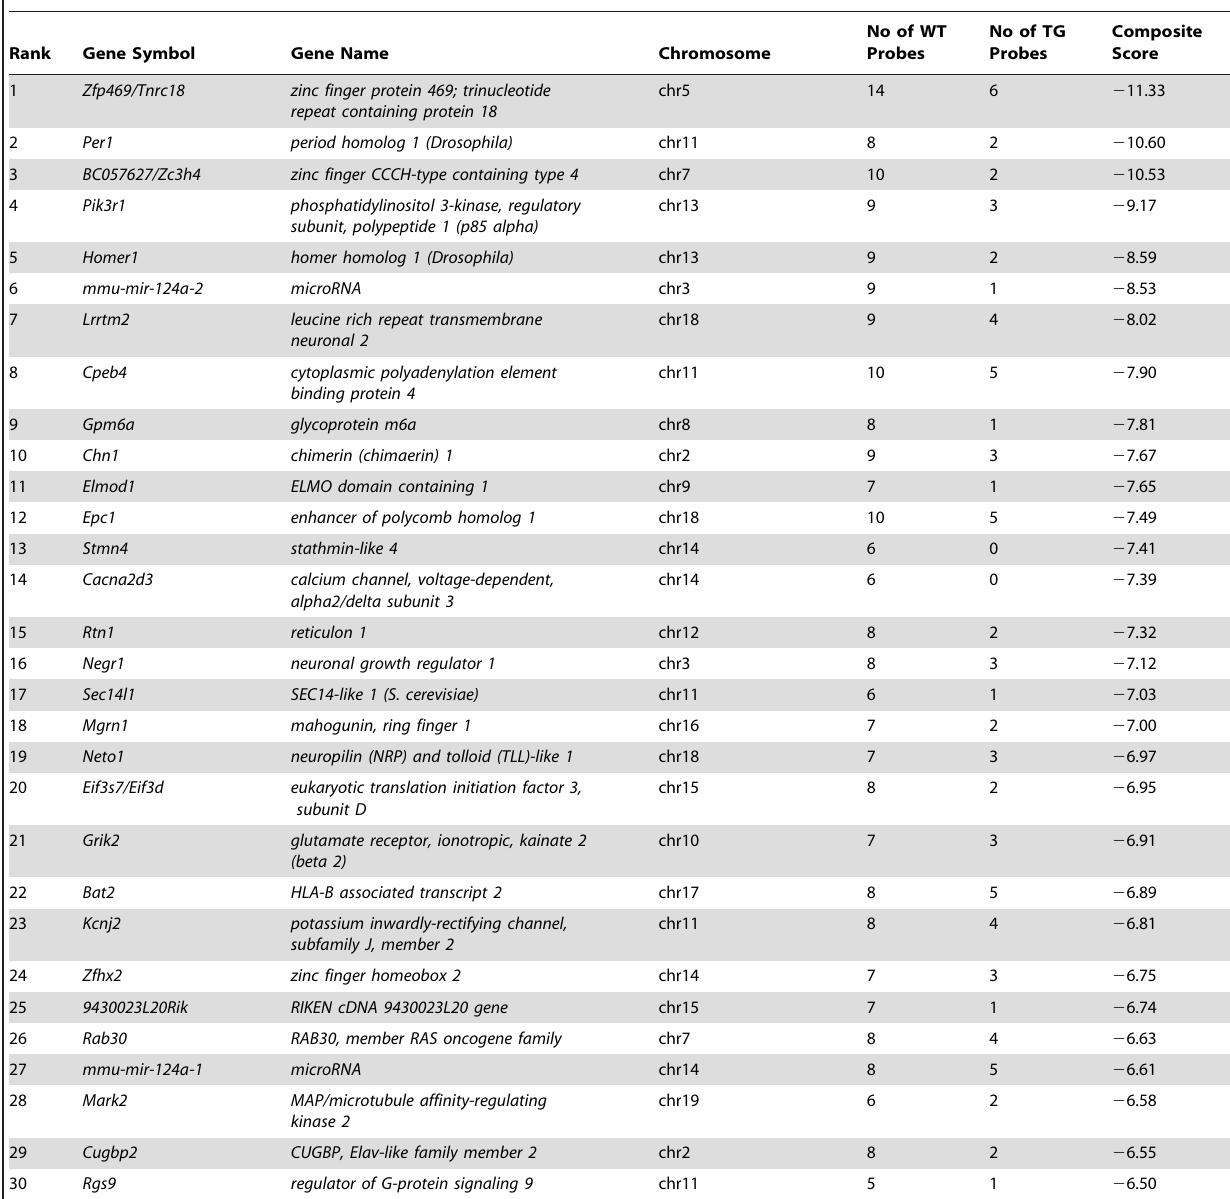
Table 1. The top genes with decreased histone H3 acetylation in TG